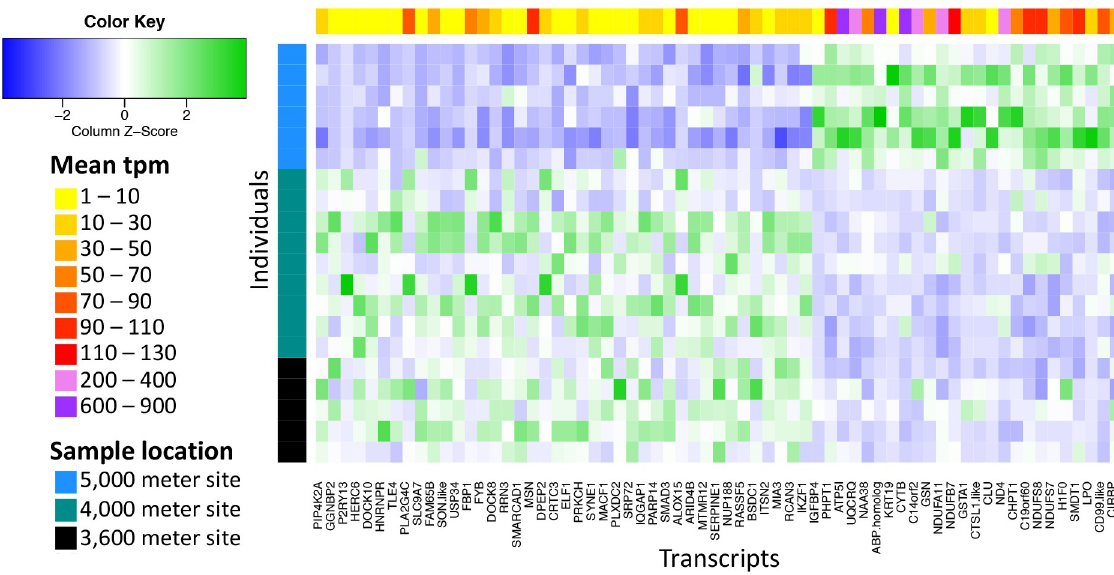
Fig 3. Heat map of transcripts that were significantly differentially expressed in the 5,000 m samples. Each row is an individual, with individuals from the 5,000 m site indicated in blue, the 4,000 m site indicated in teal, and 3,600 m site indicated in black. Each column is a transcript and the mean number of transcripts per million (TPM), a measure of expression level, for each transcript is indicated. In the heat map itself, lower expression is indicated in blue and higher expression is indicated in